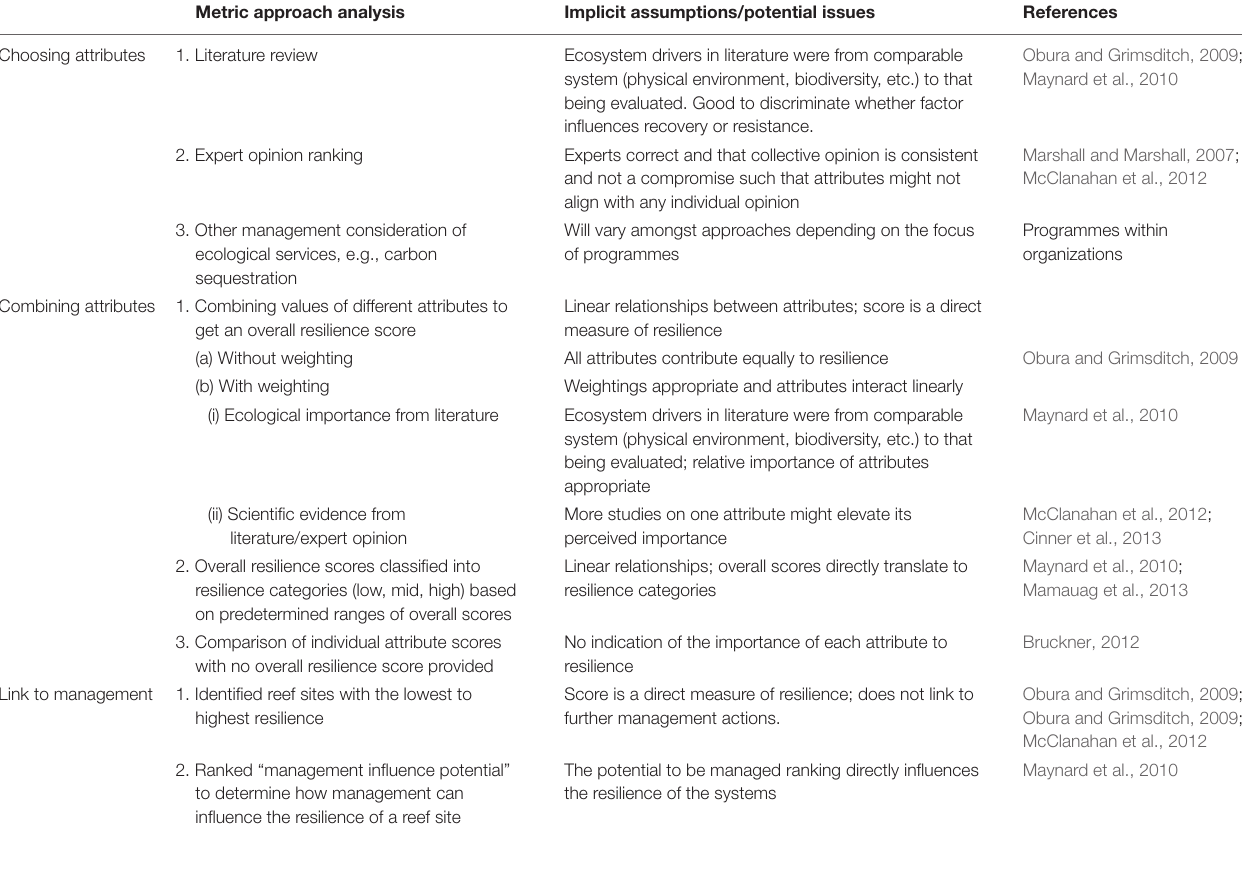
TABLE 1 | Implicit underlying assumptions of the relative vulnerability